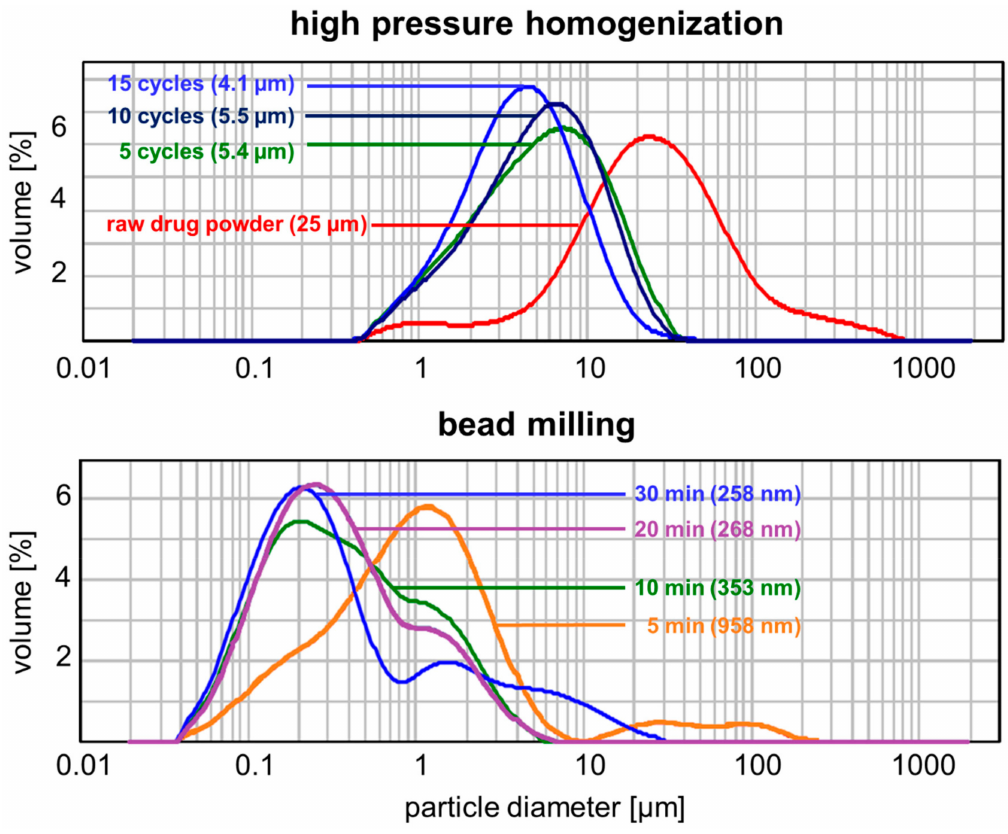
Figure 2. Laser di ff raction (LD) particle size distribution of Symurban nanocrystals produced by high-pressure homogenization (upper) and bead milling (lower), showing that only bead milling leads to appropriate size reduction of Symurban µ